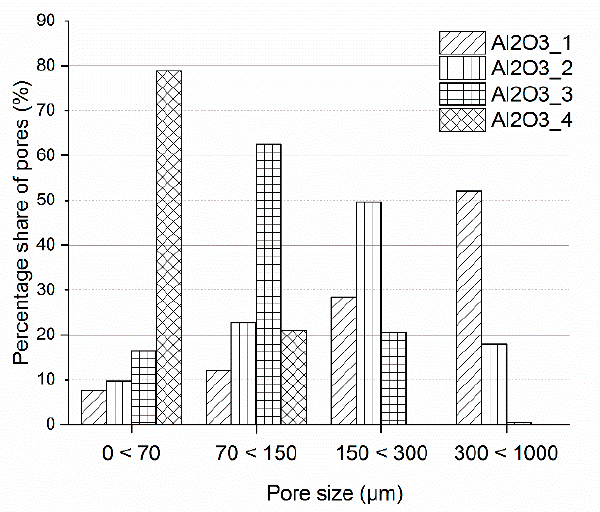
Figure 5. Pore size distribution of Al 2 O 3 _1, Al 2 O 3 _2, Al 2 O 3 _3, and Al 2 O 3 _4 ceramic